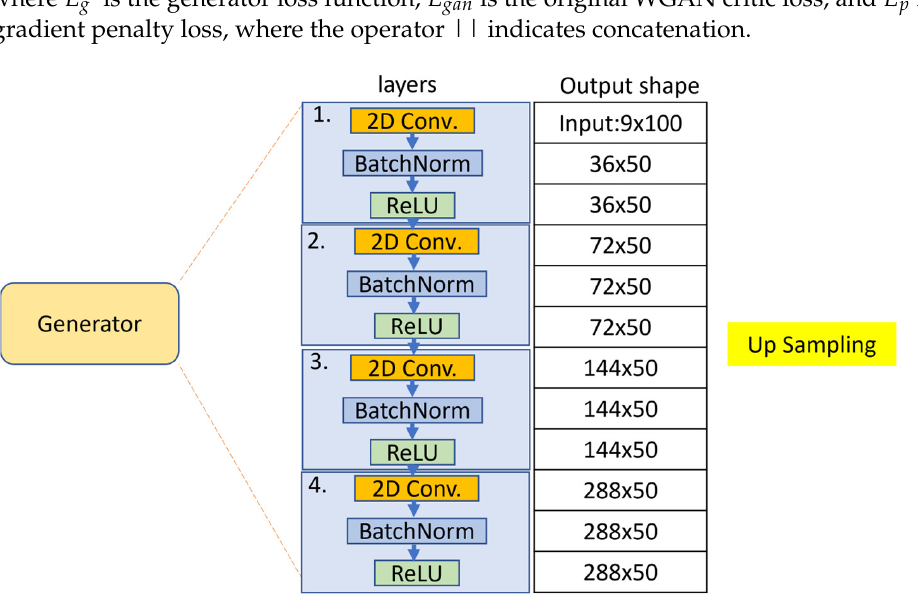
Figure 7. The block diagram of the discriminator.